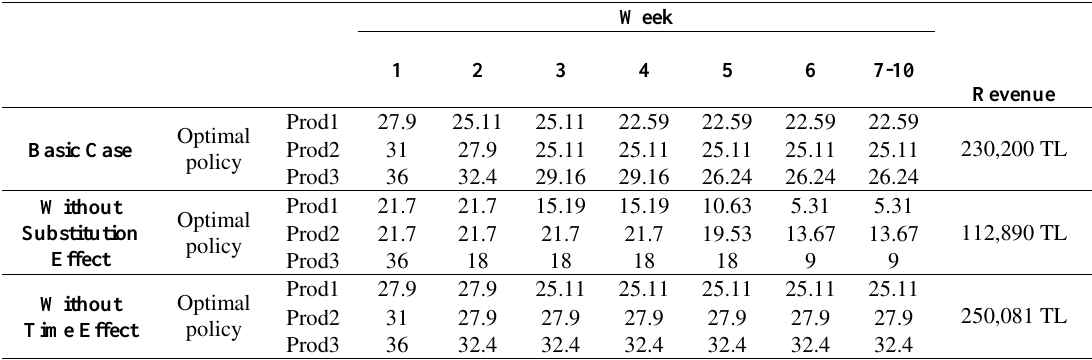
Table 6. Optimal policies obtained by Sarsa Algorithm